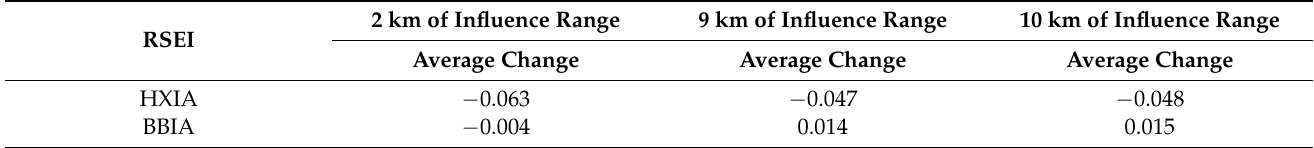
Table 2. Comparison of the impact of the two airports on the ecological environment of the surrounding areas. 2 km of Influence Range 9 km of Influence Range 10 km of Influence